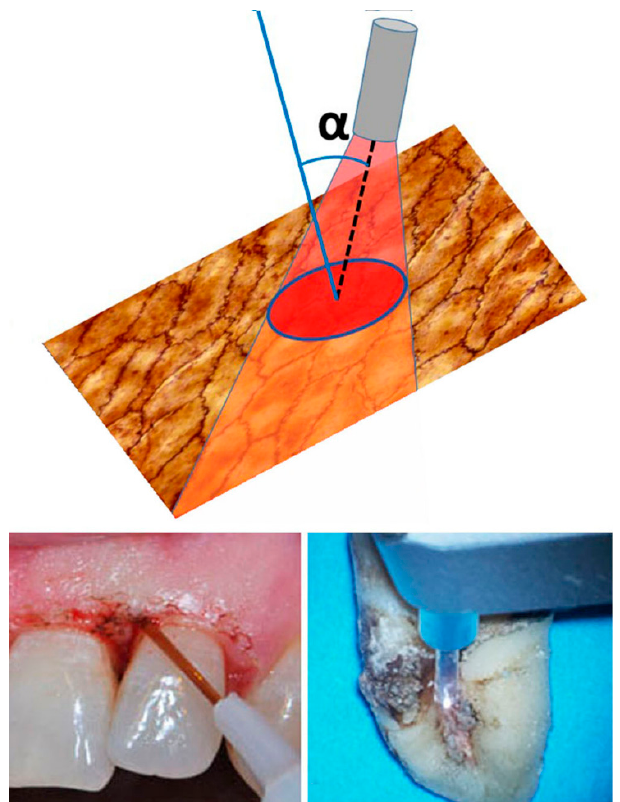
Figure 5. The diameter of the optic fiber, its angle ( α ) and distance from the target can deeply influence the actual irradiation energy delivered to the tissue. If the fiber is angled at 45°, the area of the irradiation spot increases and the overall energy is scattered proportionally. The below panels are representative of proper optic fiber angulation during diode laser photoablation of the gingival epithelium (left) and Er:YAG photoablation of calculus from a dental root (right).